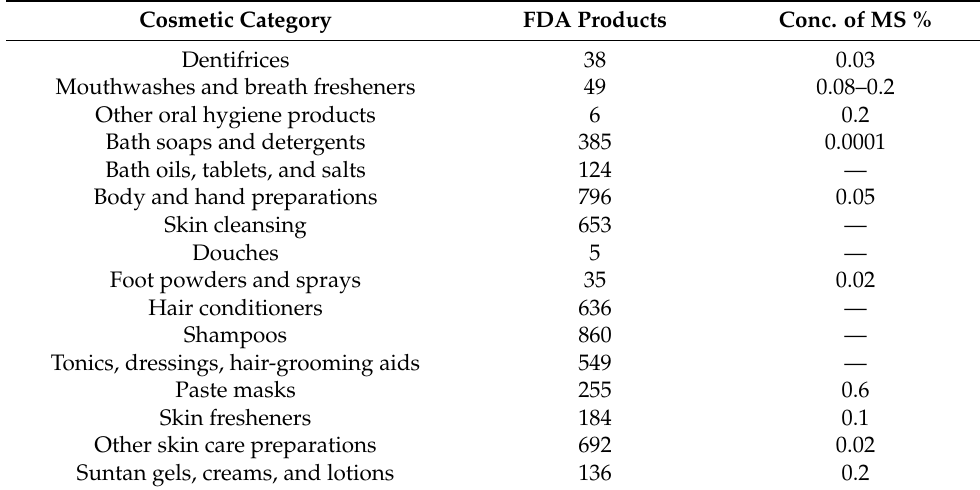
Table 1. Prevalence of methyl salicylate in consumer